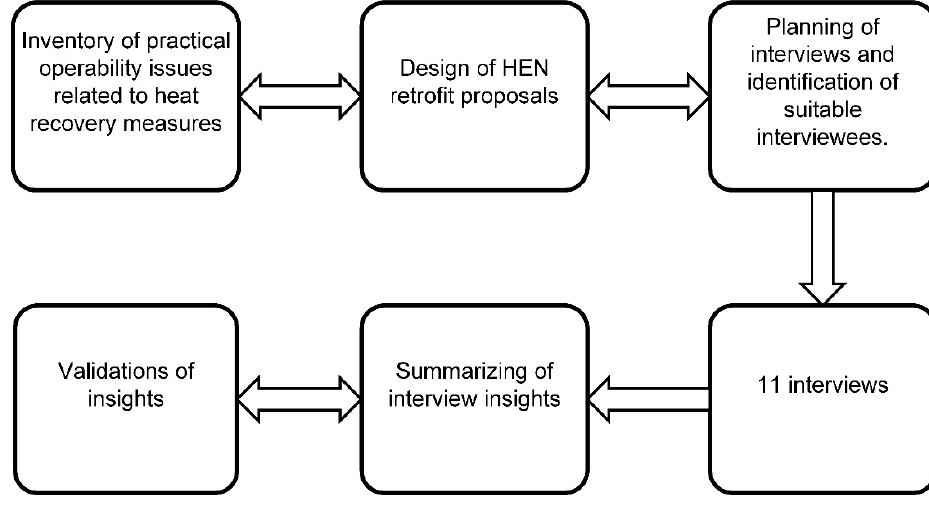
Figure 3. The work flow for the interview study.